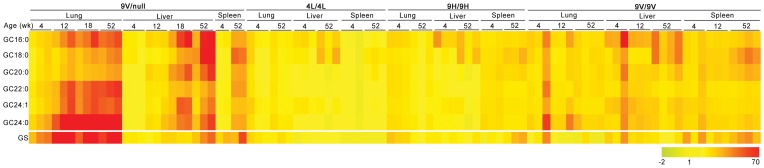
Heatmap of GC species in Gba1 mutant mice.The fold changes of GC species and glucosylsphingosine levels in individual mutant mice were age-grouped for each organ according to genotype using Gene Spring 11.5.1. The fold change was obtained for each condition relative to the average value of the age-matched WT control. The color gradients represent level of fold change. Yellow indicates that the GC species levels in the mutant were at WT levels and the fold change was 1. The gradient from yellow to red indicates GC species levels in the mutants were above WT levels and fold change were >1, and yellow to green represents <1. 9V/null mice showed age-dependent increases of all GC species and glucosylsphingosine in the liver, lung, and spleen. Predominant accumulation of GC24∶0 in the lung was in 9V/null, but not in other three mutants. GC16∶0 and GC18∶0 were major species in the liver of all four mutants with a trend toward age-dependent increases. In the spleen, C18∶0 was major increased GC species in 9V/null, 9H/9H and 9V/9V, but not in 4L/4L. Age-dependent increase of glucosylsphingosine (GS) levels was detected in all three tissues in 9V/null and the spleen of 9H/9H and 9V/9V (n = 3–4 mice).